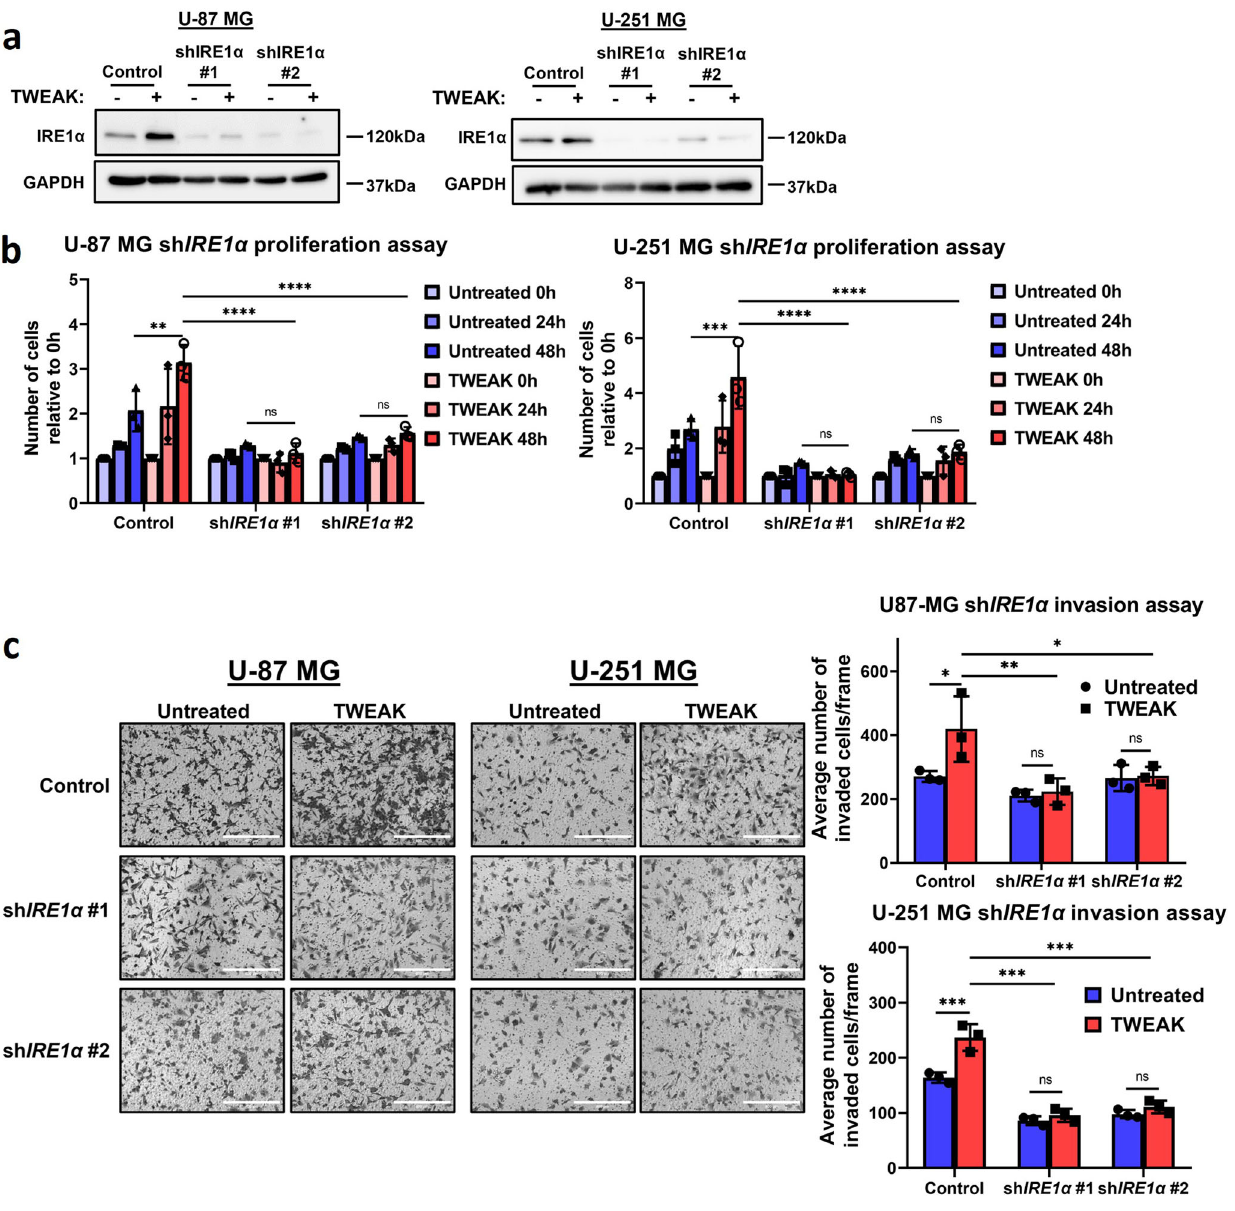
Fig. 5 p52:ETS1 cooperativity promotes glioma cell invasion and proliferation through IRE1 α . a IRE1 α protein expression analysed by western blotting to validate shRNA-mediated repression of IRE1 α in U-87 MG and U-251 MG cells. b Plot depicts the average number of cells relative to 0 h (mean ± s.d) in U-87 MG and U-251 MG sh IRE1 α . c Transwell invasion assay was performed in U-87 MG and U-251 MG sh IRE1 α cells. Representative images from n = 3 biological replicates are shown. Scale bars: 400 µ m. Plots (right) depict the average number of invaded cells (mean ± s.d) across fi ve fi elds. All functional experiments were compared in the presence and absence of TWEAK treatment. Two-way ANOVA was used for all statistical analyses. * P < 0.05; ** P < 0.01; *** P < Plasmids . lentiCRISPRv2 (Addgene; Cat #52961) was used for generating ETS1 KD in U-87 MG and U-251 MG cell lines. sgRNAs targeting ETS1 and NFKB2 were designed on Benchling 48 , where sgRNAs with the highest On-Target score and Off-Target score were selected (Supplementary Table 1). pLKO.TRC (Addgene; Cat#10878) was used for generating shIRE1 α in U-87 MG and U-251 MG cell lines (Supplementary Table 1). EGFP in pLJM1-EGFP (Addgene; 19319) with its puromycin resistance gene substituted with hygromycin resistance. Subsequently, pLJM1-sTWEAK was used